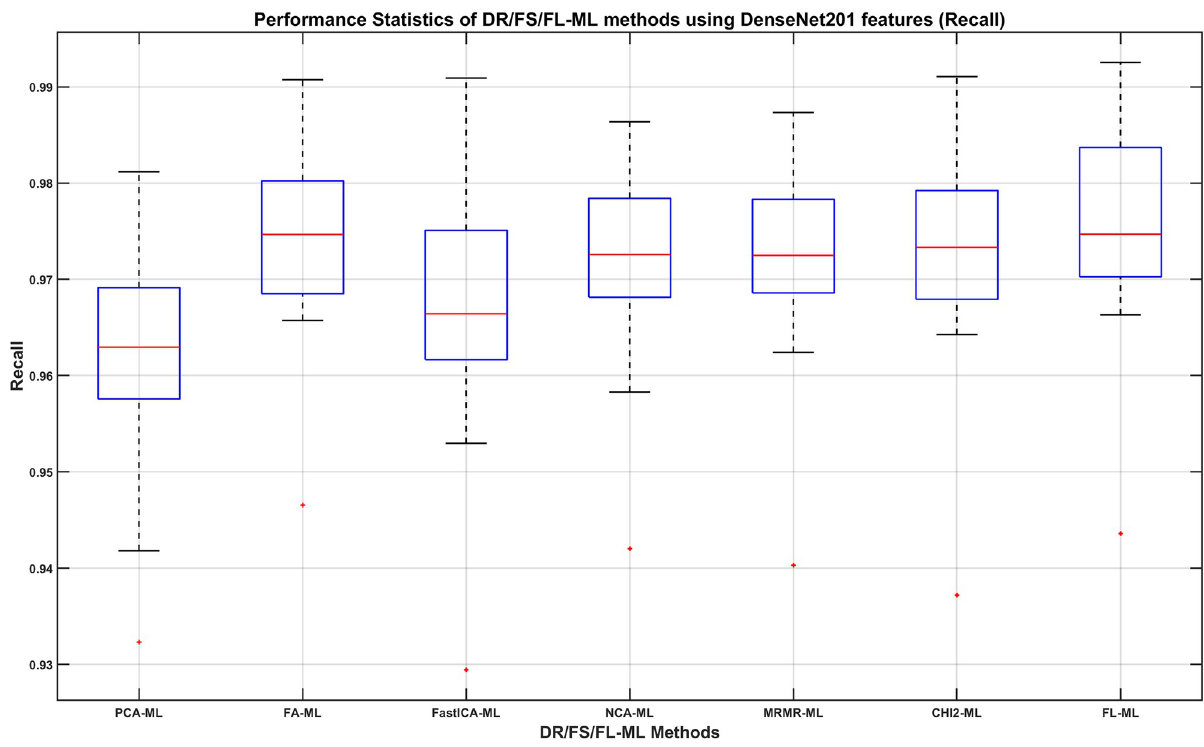
Fig 10. The Recall of DR/FS/FL-ML methods using DenseNet201 features. The ML learners used can be found in the second row of Table 9.